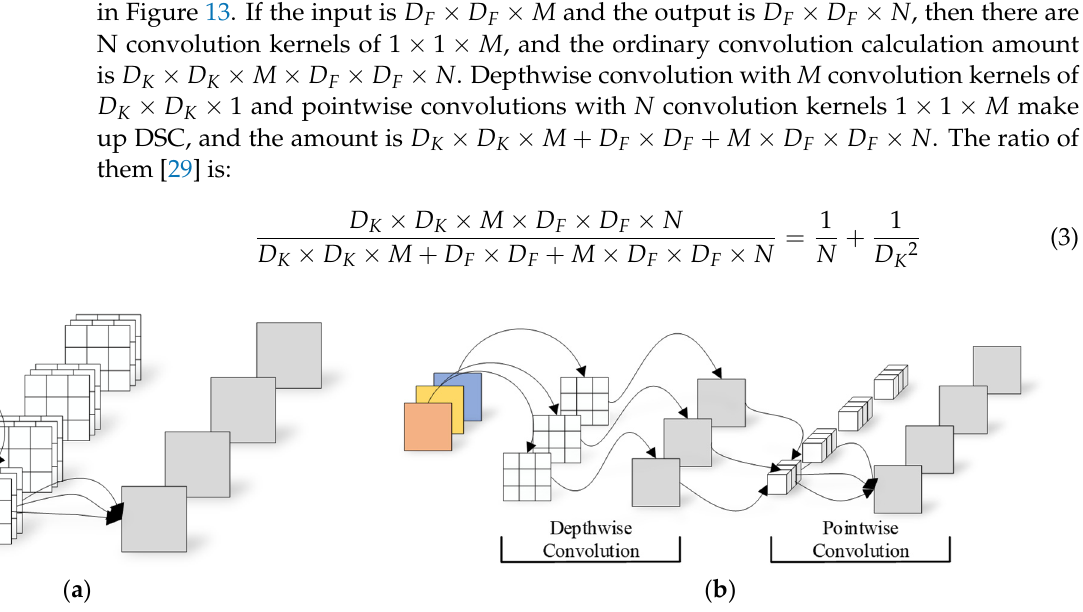
Figure 12. scSE-LHRNet network structure.